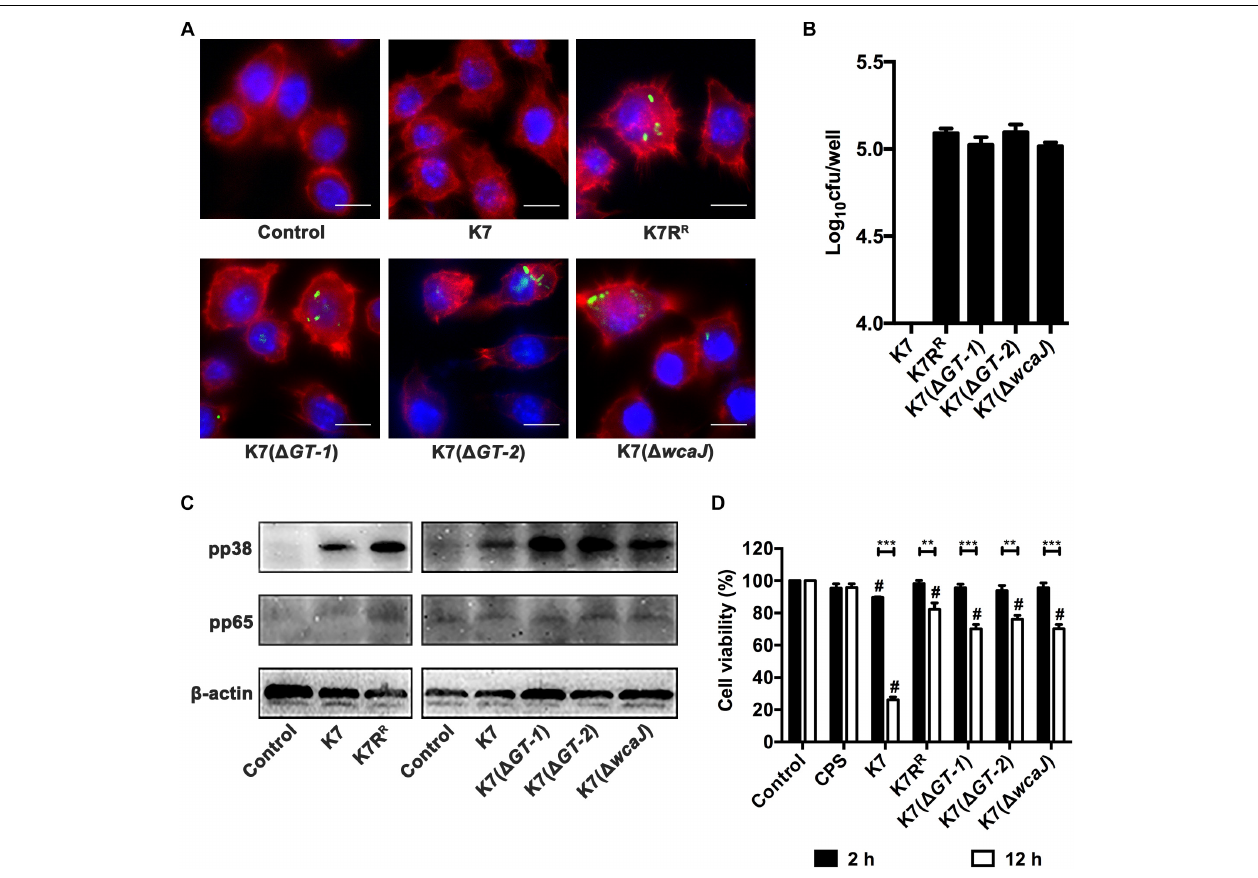
FIGURE 7 | Endocytosis, activation and cytotoxicity of RAW264.7 cells after incubation with different K. pneumoniae strains. (A) Immunofluorescence analysis of endocytosis effects of RAW264.7 cells after incubation with different K. pneumoniae strains. K. pneumoniae K7, K7R R , K7( (cid:49) GT-1 ), K7( (cid:49) GT-2 ), and K7( (cid:49) wcaJ ) were stained with SYTOTM 9 Green Fluorescent Nucleic Acid Stain. The K. pneumoniae strains were then co-incubated with RAW264.7 cells in antibiotic-free supernatants. Cytoskeleton and nuclei were stained with Phalloidin-iFluor 555 and Hoechst 33342, respectively. The endocytosis of these K. pneumoniae strains in RAW264.7 cells was determined with a laser scanning confocal microscope and then observed at a magnification 1000 × (scale bar, 10 µ m. Images shown are representative of three independent experiments). (B) The bacterial loads of intracellular K. pneumoniae in RAW264.7 cells. Cells (5 × 10 5 ) were incubated with K7, K7R R , K7( (cid:49) GT-1 ), K7( (cid:49) GT-2 ), and K7( (cid:49) wcaJ ) at 37 ◦ C for 2 h. After gentamicin treatment and cell lysis, bacterial loads in each cell samples were determined by plating. Data represent the mean ± SEM of triplicate experiments. (C) Expression levels of pp38 and pp65 in RAW264.7 cells after incubation with K. pneumoniae K7, K7R R , K7( (cid:49) GT-1 ), K7( (cid:49) GT-2 ), and K7( (cid:49) wcaJ ). Untreated cells were used as controls. β -actin served as a loading control. (D) Cytotoxicity analysis of RAW264.7 cells after incubation with purified CPS from K7 (10 µ g) or different K. pneumoniae for 2 or 12 h. Cells without any treatment were served as controls and their viability was set as 100%. The statistical differences between different treatment groups and control group were labled with # ( P < 0.05); the statistical differences of the same treatment groups at different time periods (2 or 12 h) were labled with ∗∗ ( P < 0.01), and ∗∗∗ ( P < 0.001). Data represent the mean ± SEM of triplicate